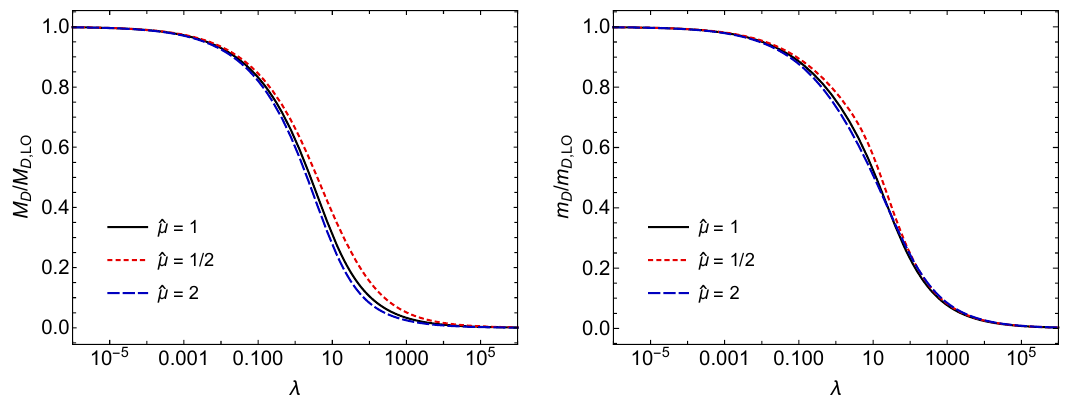
Figure 8 . Numerical solution of the gap equations for M D and m D as a function of (cid:21) for the case m q = 0. In both panels the results are scaled by their corresponding leading-order weak-coupling